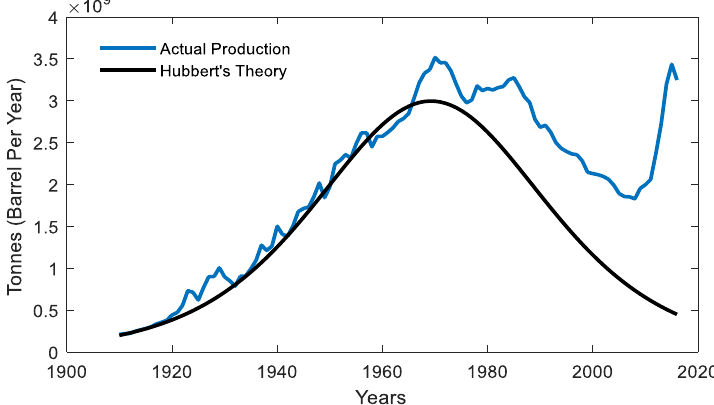
Figure 3. Hubbert’s peak prediction vs. actual production in the USA [37,39].